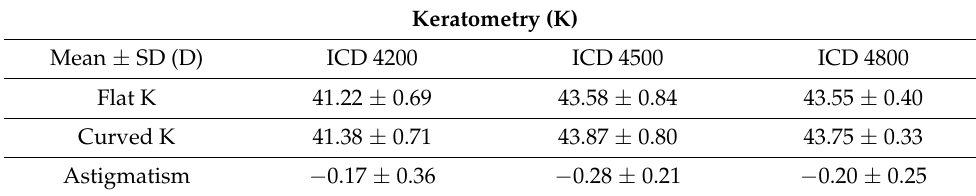
Table 2. Keratometry over the anterior surface of the different ScCLs